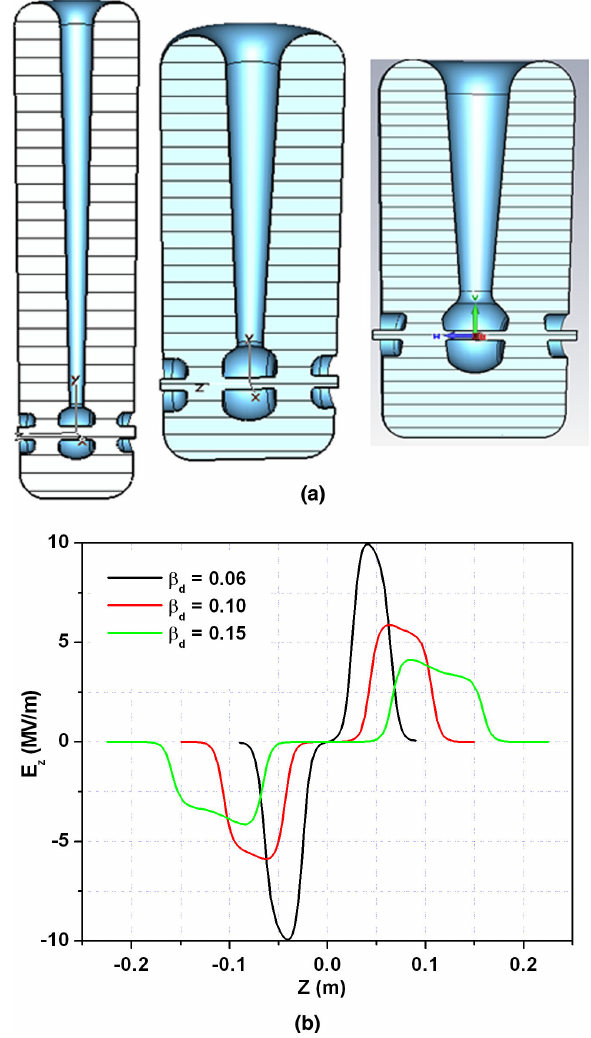
(b) CST simulated on-axis electric field for three resonators.